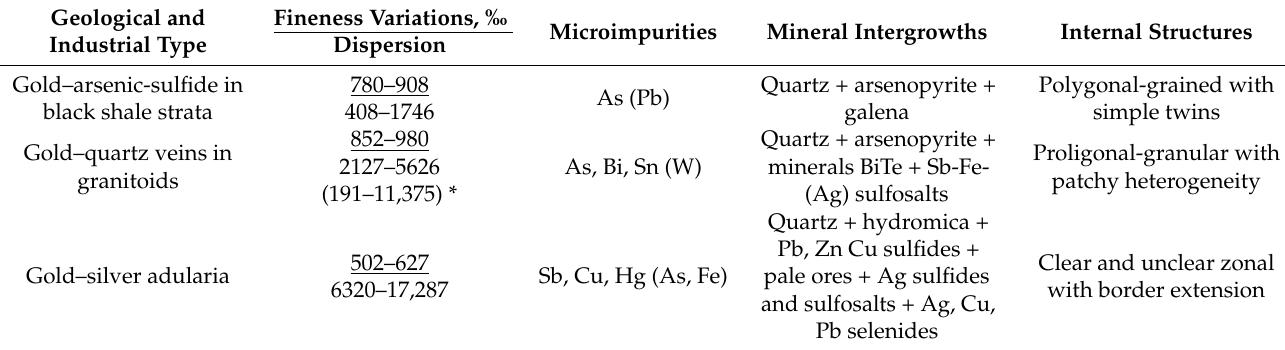
Table 5. Main typomorphic features of native gold for various